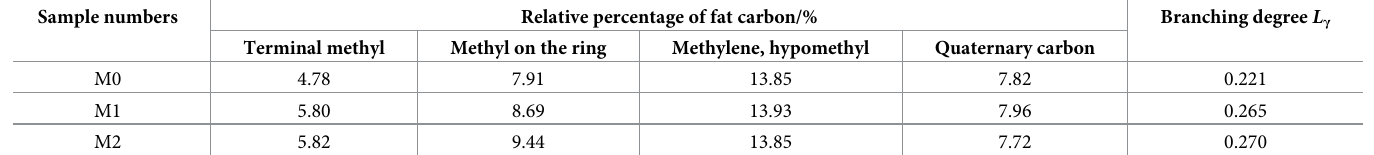
Table 9. The branched chain degree of lignite.